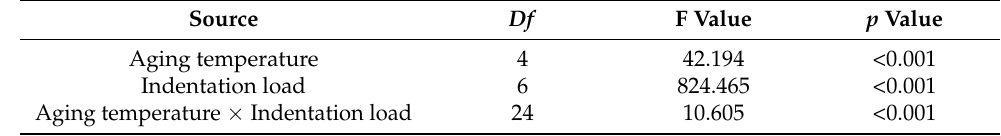
Figure 8. Variation of the biaxial strength of 3Y-TZP indented at loads ranging from 0 to 490 N as a function of aging temperature. The results show that the indented strength of preaged specimens increases with LTD. The specimens were aged for 10 h after sintering at 1550 ◦ C for 20 h. The strength of as-sintered specimen is displayed at the scale of 25 ◦ C. Table 3. Summary of ART ANOVA for the biaxial flexural strength of indented 3Y-TZP after ag- ing.